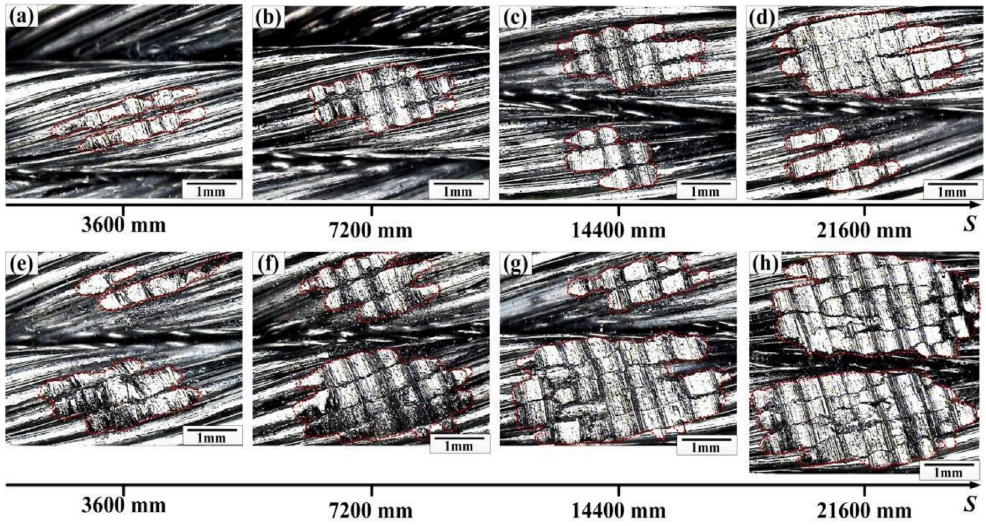
Figure 10. Optical micrographs of the wear scars under different loads. ( a – d ) Load: 50 N, stroke: 20 mm; ( e – h ) load: 150 N, stroke: 20 mm.